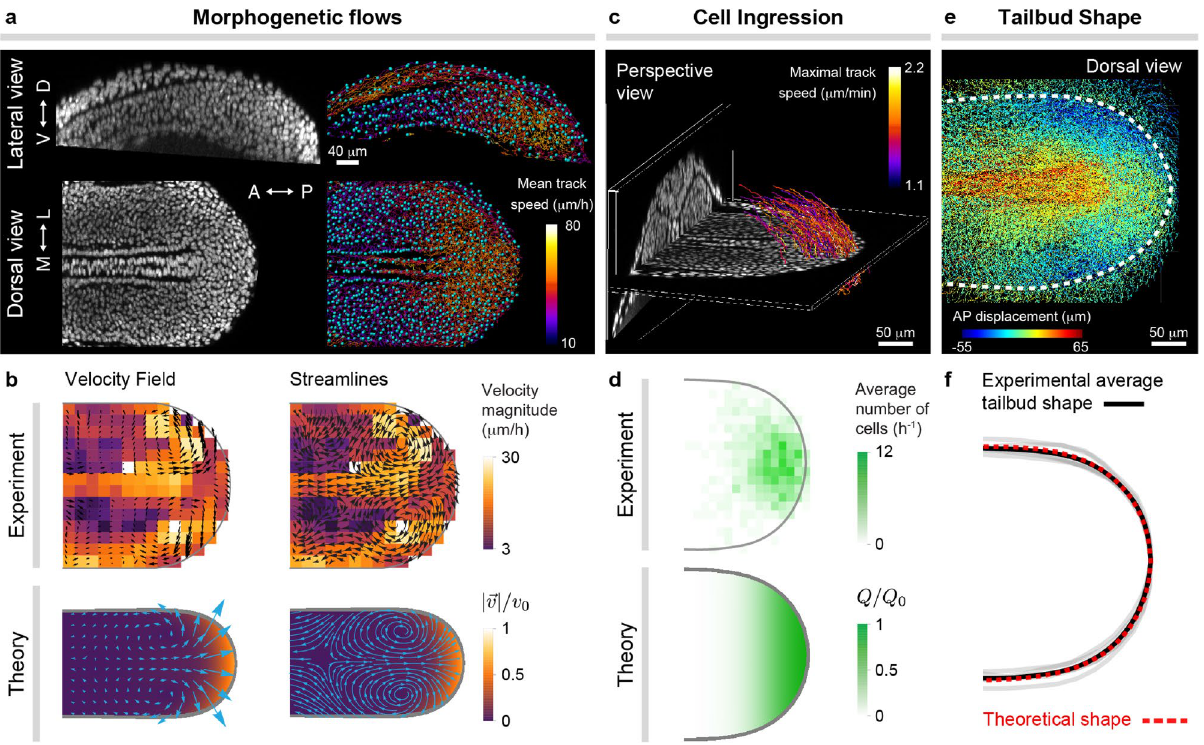
Figure 5. Morphogenetic flows and tissue shape during zebrafish posterior body axis elongation. ( a ), Confocal lateral and dorsal sections of nuclei (gray) in posterior tissues of a zebrafish embryo at the 10 somite stage (left). Results of nuclear (cell) tracking showing a subset of identified nuclei (blue) and associated tracks (trajectories), color-coded according to their mean speed. ( b ), Experimentally measured and theoretically obtained velocity field and streamlines of the morphogenetic flows in ventral tissues. ( c ), Perspective 3D view of a confocal stack through elongating posterior tissues, showing a D–V section at the boundary between dorsal and ventral tissues and a AP section far from the posterior end. Tracks of cells entering ventral tissues from DM tissues are shown and color-coded according to their maximal speed. ( d ), Measured frequency map of cells entering the MPZ from DM tissues and theoretically assumed spatial distribution of the same quantity, namely Q ( x , y ). ( e ), Dorsal view of cell (nuclear) trajectories in posterior tissues, color-coded according to the magnitude of their AP displacement. The boundary of ventral tissues is shown as a thick dashed line and determines the shape of the elongating posterior body. ( f ), Comparison of experimentally measured and theoretically predicted shapes of the posterior elongating tissue. The simulation results in ( b , d , f ) are all for the same parameters ( (cid:31) µ / (cid:31) Q = 1.5 , σ A / P C = 0.1 , σ P / P C = 0.02 , σ C / P C = 0.0001 for low tissue surface tension are observed experimentally, suggesting that capillary stresses are irrelevant (neg- ligible compared to other stresses) during posterior body elongation in zebrafish. This is in agreement with our estimated values for the different stress scales, which indicate that capillary stress ( ∼ 1 Pa; see above) is much lower than all other stresses in the system. Beyond morphogenetic flows, tracking cellular movements in 3D allows a direct quantification of the spatial distribution of DM cells entering ventral tissues. We specifically tracked DM cells as they moved from DM tis- sues into ventral tissues (Fig. 5c; Methods) and obtained their frequency map (Fig. 5d; Methods), which should correspond to the theoretically defined rate of cell ingression from DM tissues into the MPZ, Q . Our assumed input function Q depends on the tissue pressure and is therefore also part of the solution of the simulations, even if the AP spatial extension is limited to a length scale (cid:31) Q by construction (Fig. 5d). Experimentally, cells enter the MPZ through an approximately elliptical region adjacent to the posterior-most end of the body axis. While the input function Q and the experimentally measured frequency map of cells entering ventral tissues are slightly different, they share a key feature: cells enter ventral tissues within a limited distance ( (cid:31) Q ) from the posterior end. Indeed, the simulations reproduce the essential features of the experimental data despite these differences, suggesting the exact spatial distribution of Q is not essential as long as it is localized at the posterior-most end of the extending body axis. One of the most important aspects of tissue morphogenesis is the tissue shape. In order to measure the shape of the tissue during posterior elongation, we also make use of the cell movements. Cell trajectories across the entire tissue seen from a dorsal view display distinctive AP displacements in the PSM and MPZ compared to surrounding tissues, allowing us to determine the boundary of these tissues (Fig. 5e; Methods). We quantified the 2D projected tissue shape and compared it to the tissue shape predicted in our simulations during unidirectional